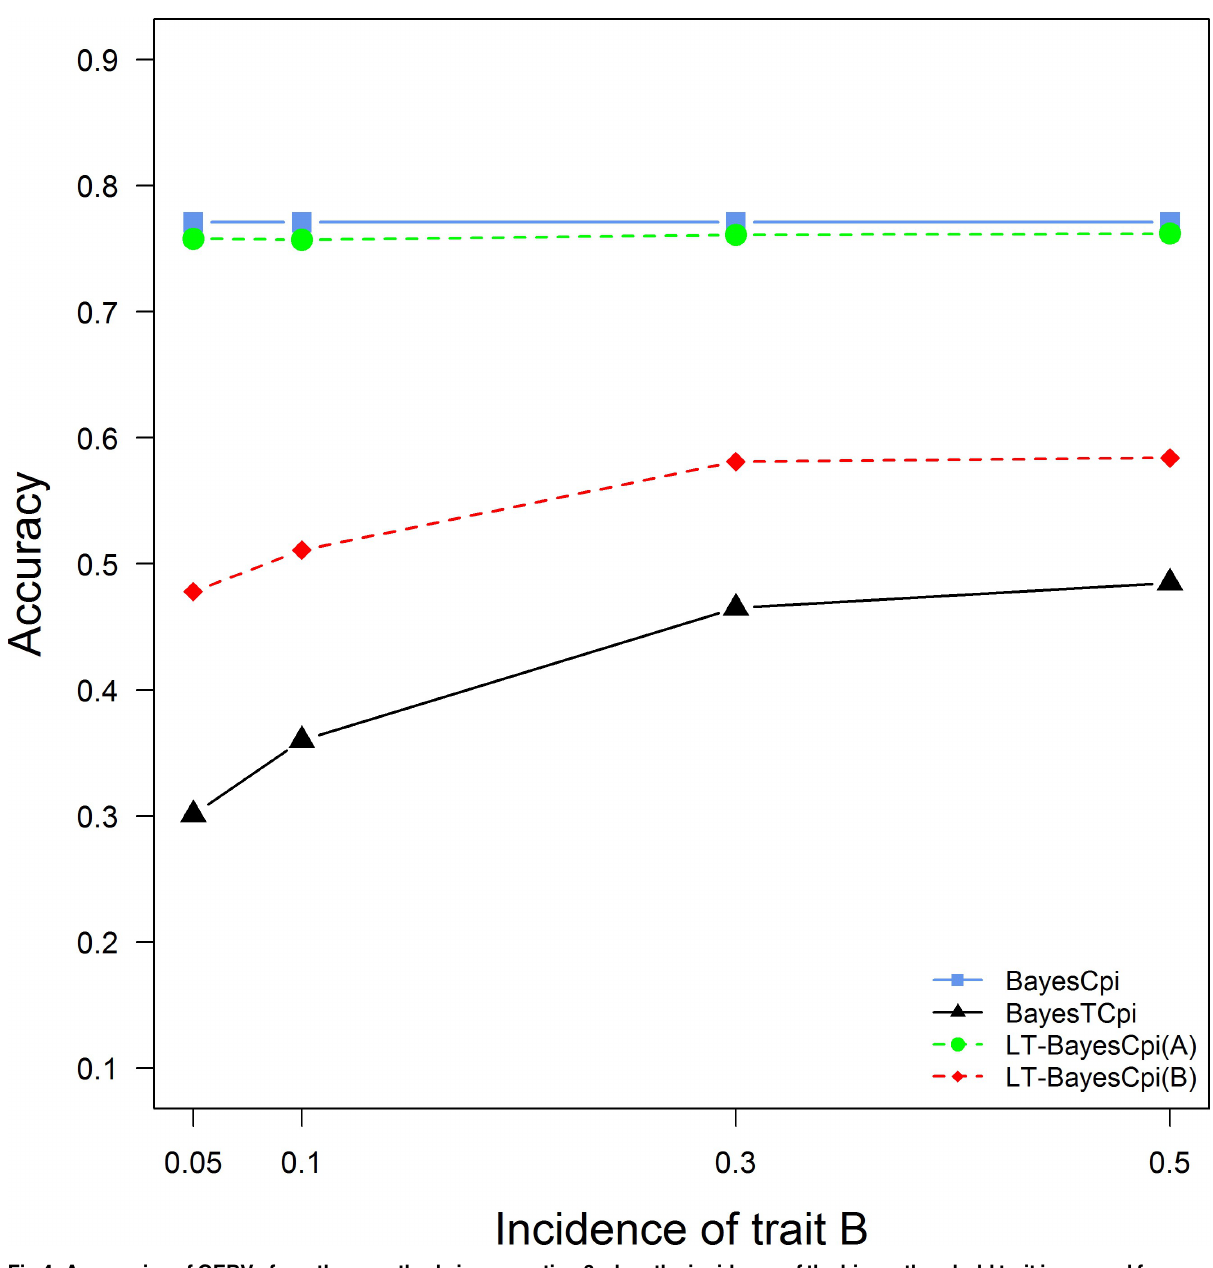
PLOS ONE | https://doi.org/10.1371/journal.pone.0175448 April 14,